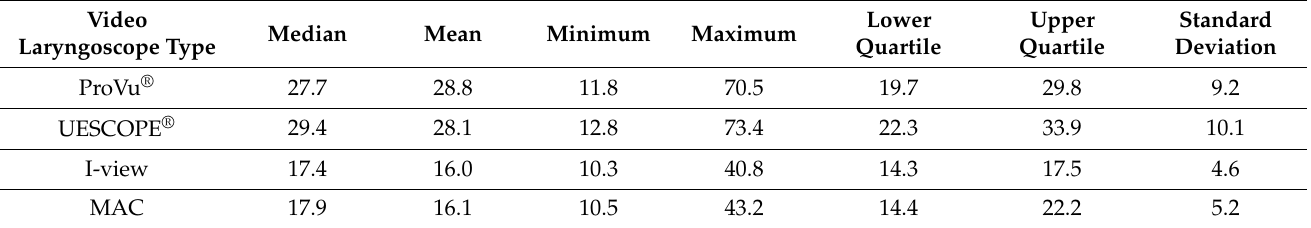
Table 1. Time characteristics for successful intubation